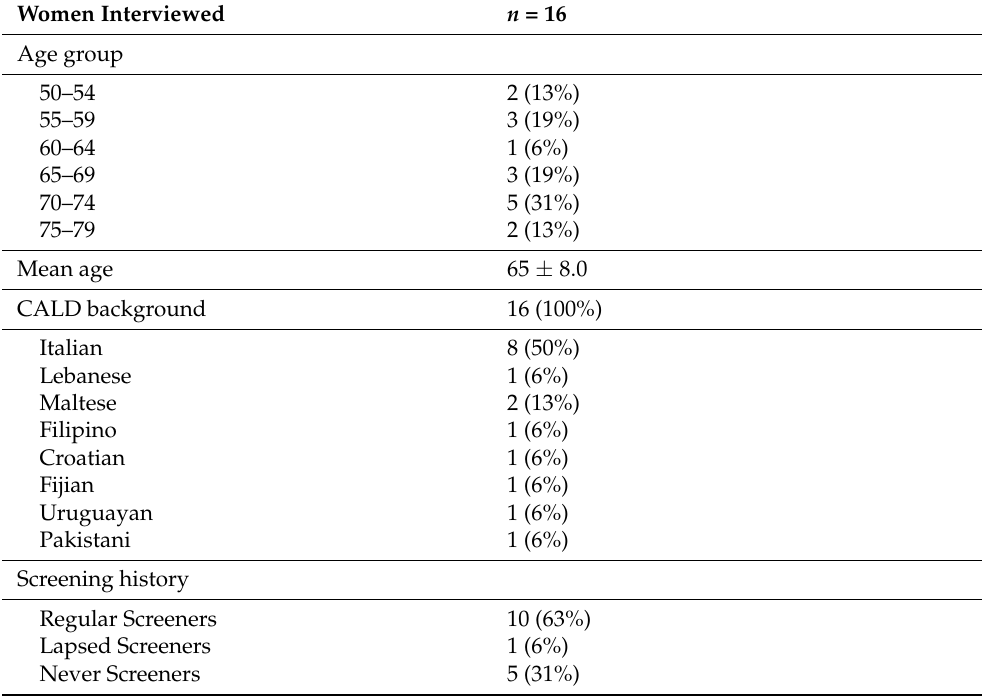
Table 1. Demographic characteristics of